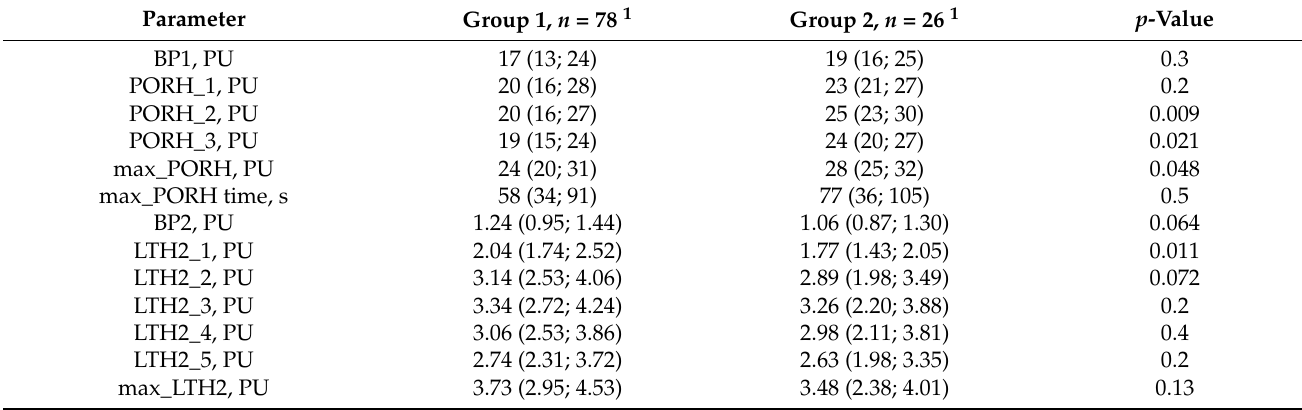
Table 2. Comparison of blood flow parameters in the groups of patients. Me (LQ; UQ) are calculated for quantitative